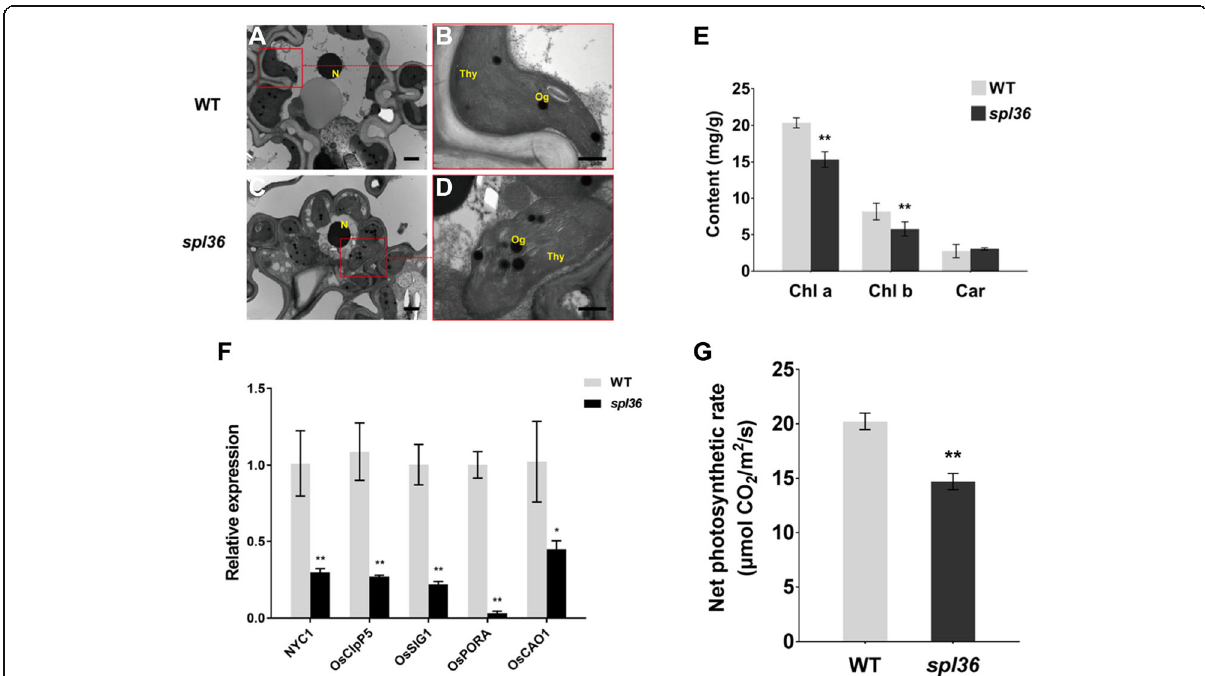
Fig. 2 Chloroplast development and net photosynthetic rate in wild-type and mutant plants. a-d Chloroplast ultrastructure in wild-type and mutant plants, a, c : leaf cells at 6000X; b, d : leaf cells at 40,000X; N: nucleus; Thy: chloroplast; Og: osmium granules; Bar = 1 μ m. e Chlorophyll content in the leaves of wild-type and mutant plants at the tillering stage. f Relative expression of chloroplast development and pigment synthesis-related genes. g Net photosynthetic rate in wild-type and mutant plants at the tillering